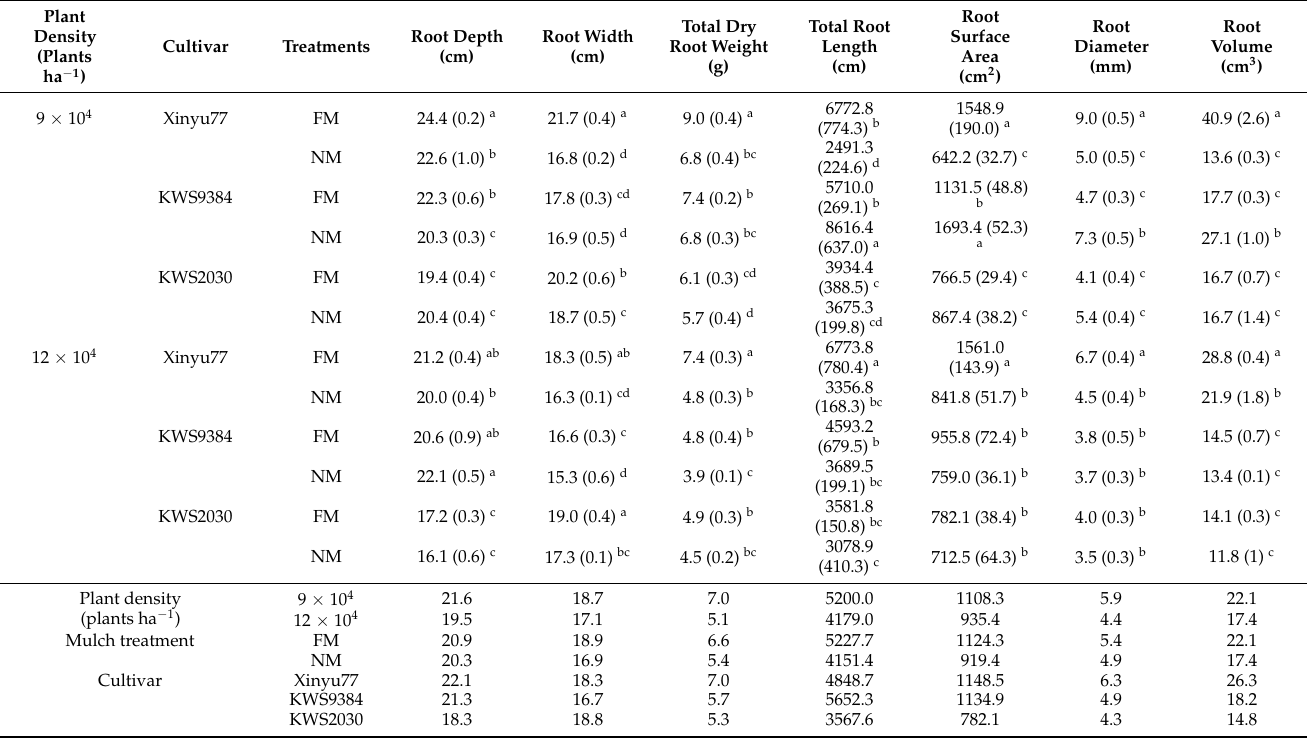
Table 2. Differences of maize root morphology between film mulch (FM) and no-film (NM) plant- ing.